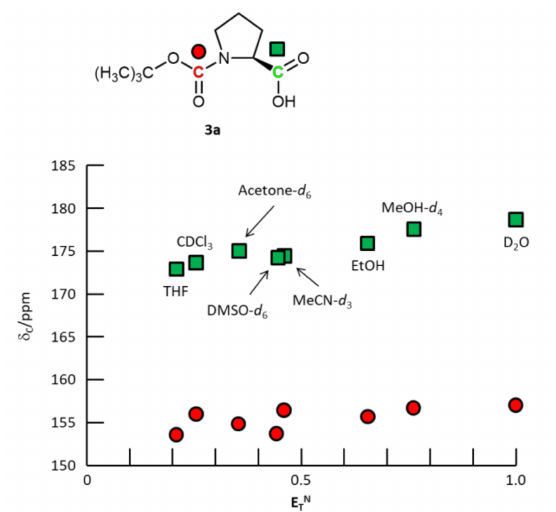
Figure 3. 13 C NMR chemical shifts of the carbonyl carbons of N -Boc-L-proline-OH 3a